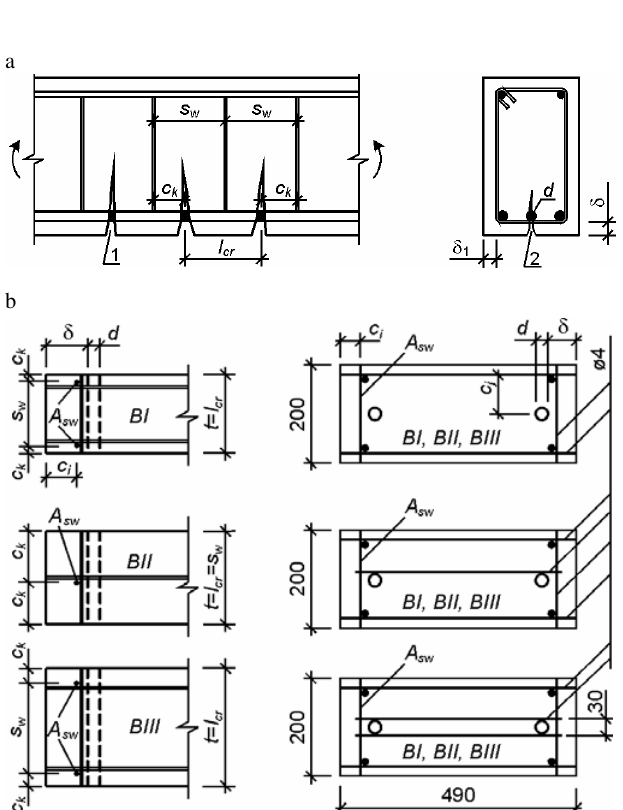
Fig 4. Cracking in reinforced concrete member (a) and dimensions and reinforcement of the specimens